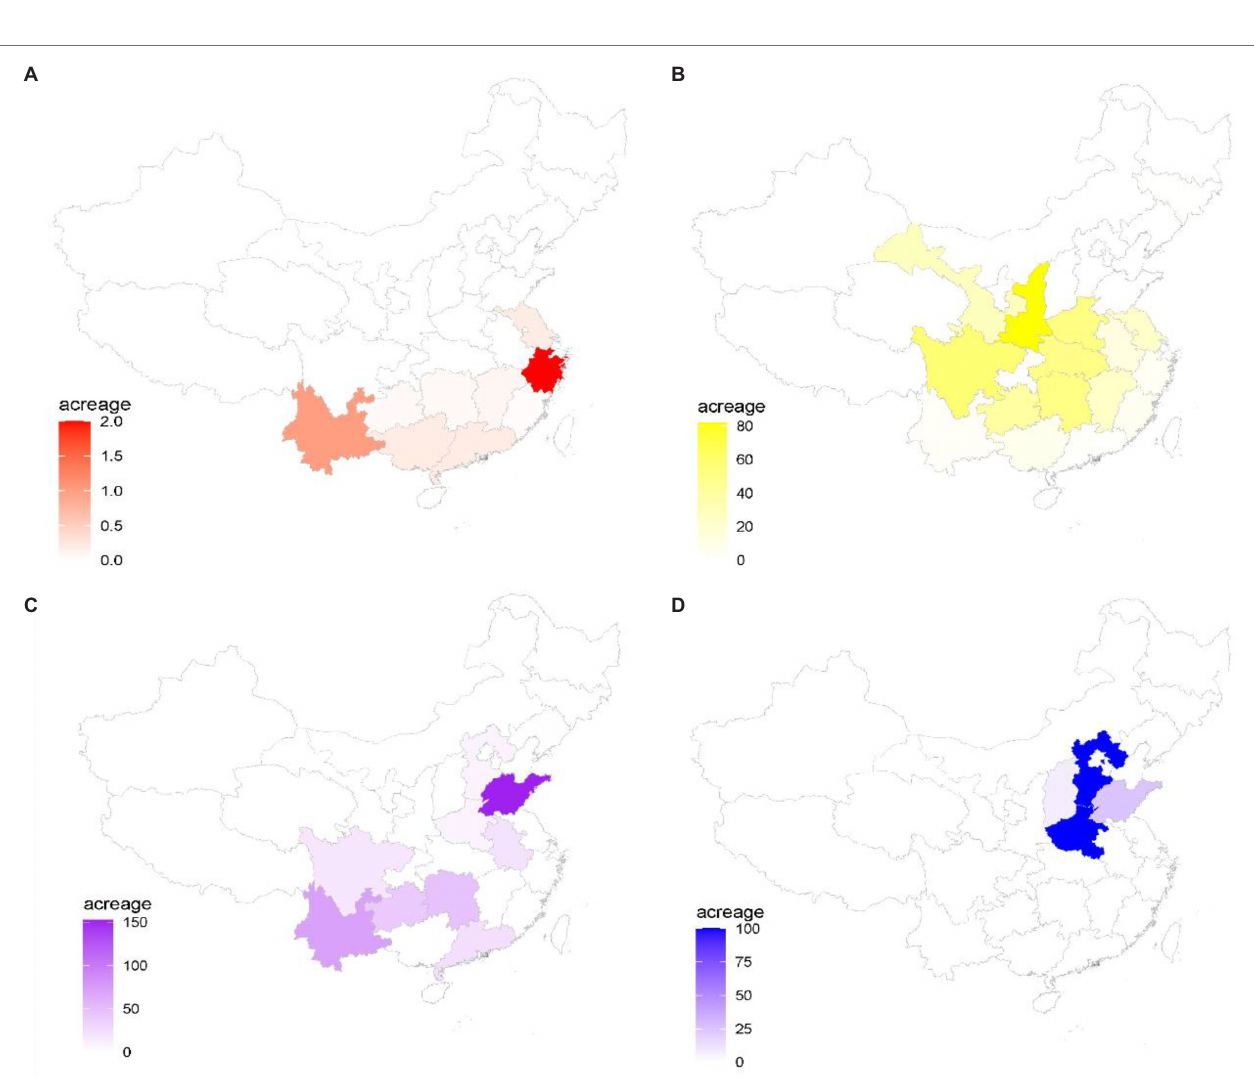
FIGURE 3 | Industry distribution and covered areas of four representative species in China. (A) Dendrobium officinale ; (B) Eucommia ulmoides ; (C) Zingiber officinale ; and (D) Dioscorea zingiberensis . A color scale bar is shown the acreage size of species in each province of